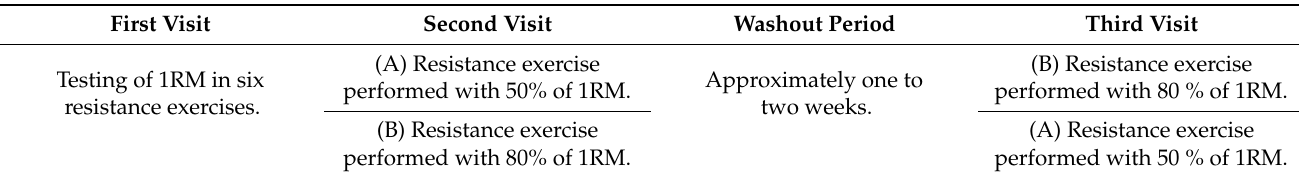
Table 1. Overview of the study procedures, including exercise sessions (A) 50% of 1RM and (B) 80% of 1RM. First Visit Second Visit Washout Period Third Visit Testing of 1RM in six resistance